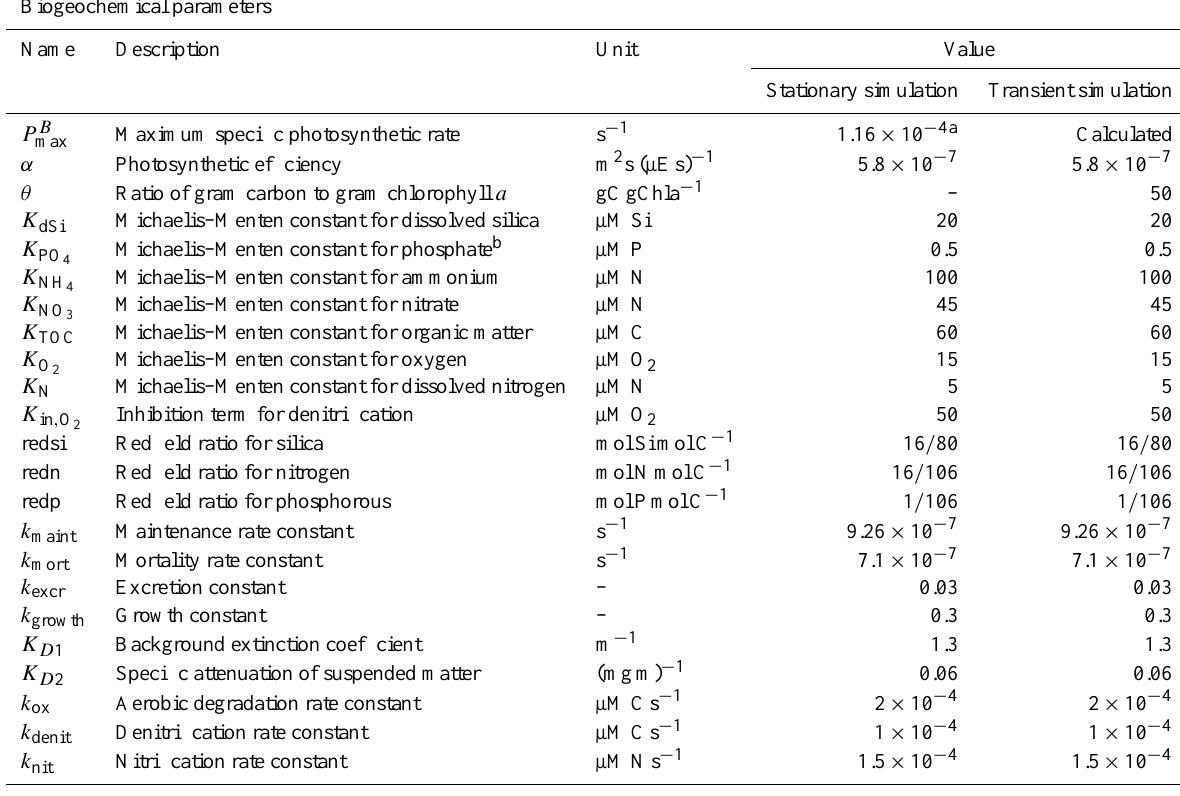
Table 4. Values for biogeochemical parameters used in C-GEM for stationary and transient simulations. All rates are defined at 278.15K. a from Vanderborght et al. (2007). b from Billen and Garnier (1997). All other values are from Arndt et al. (2009).